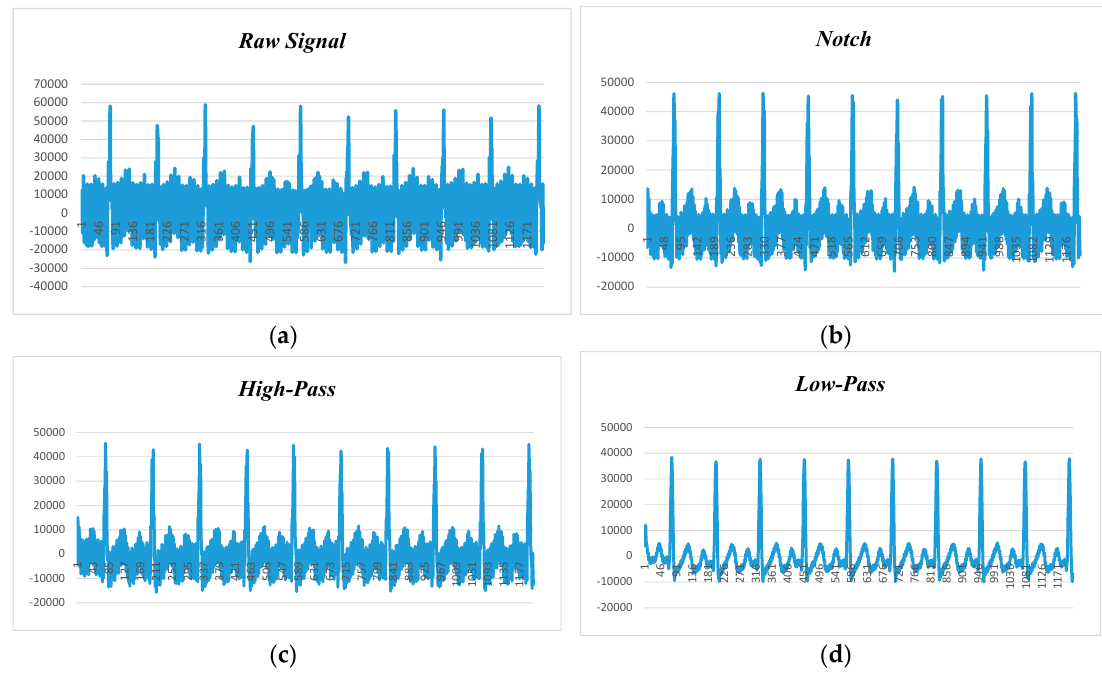
Figure 11. ECG data filtering at 120 BPM and 50 Hz noise: ( a ) raw data; ( b ) notch filter; ( c ) high-pass filter (HPF); ( d ) low-pass filter (LPF).